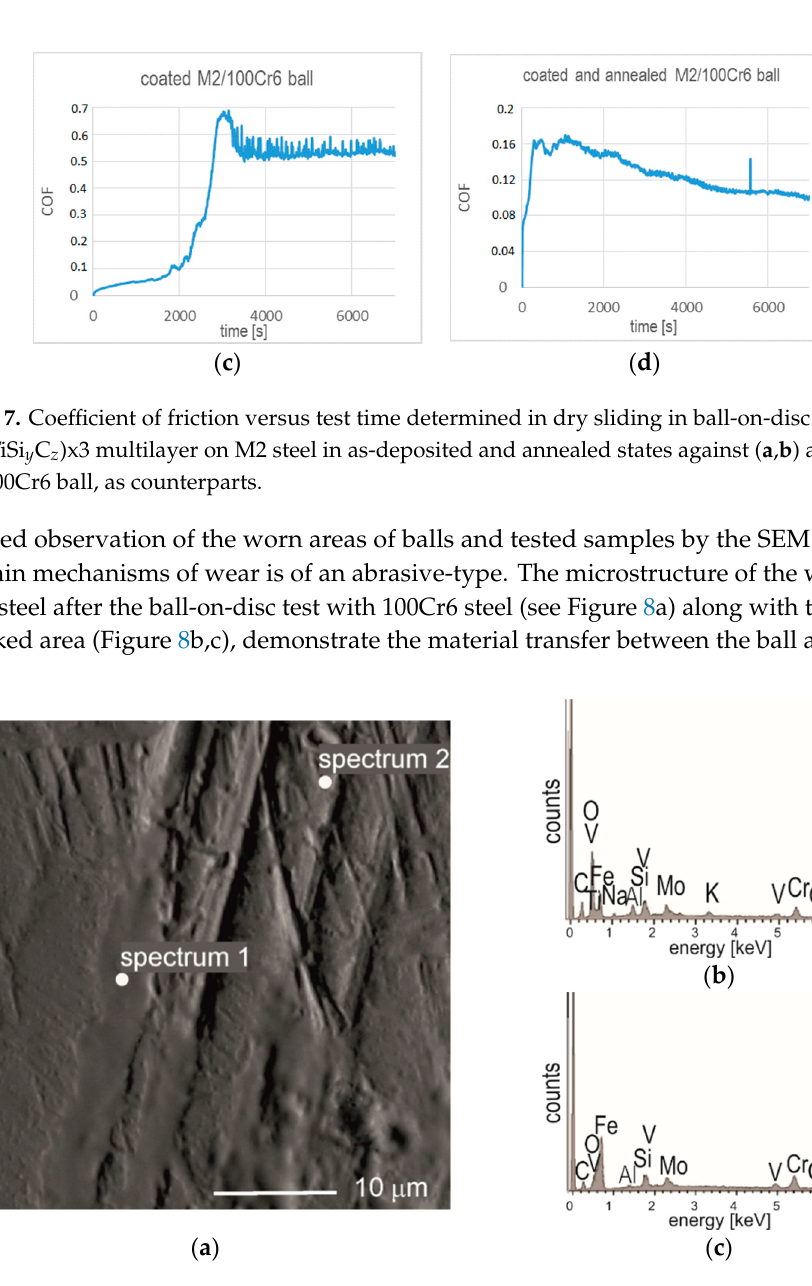
Figure 8. (a) BET image (Backscattered Electron image in Topography mode) of the worn track, ball- on-disc test, 100Cr6 ball, of (TiB x /TiSi y C z )x3 multilayer on M2 steel, with marked areas for EDS